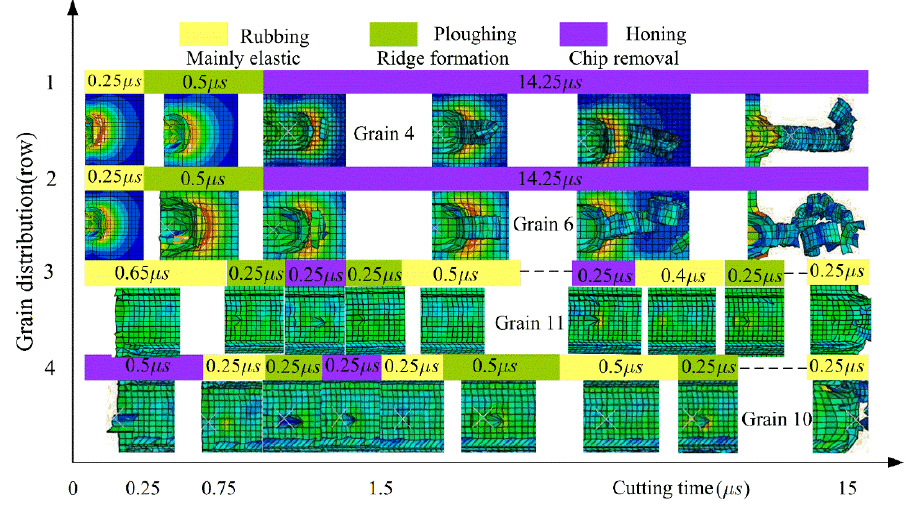
Figure 8. Distribution of abrasive gains and honing status.